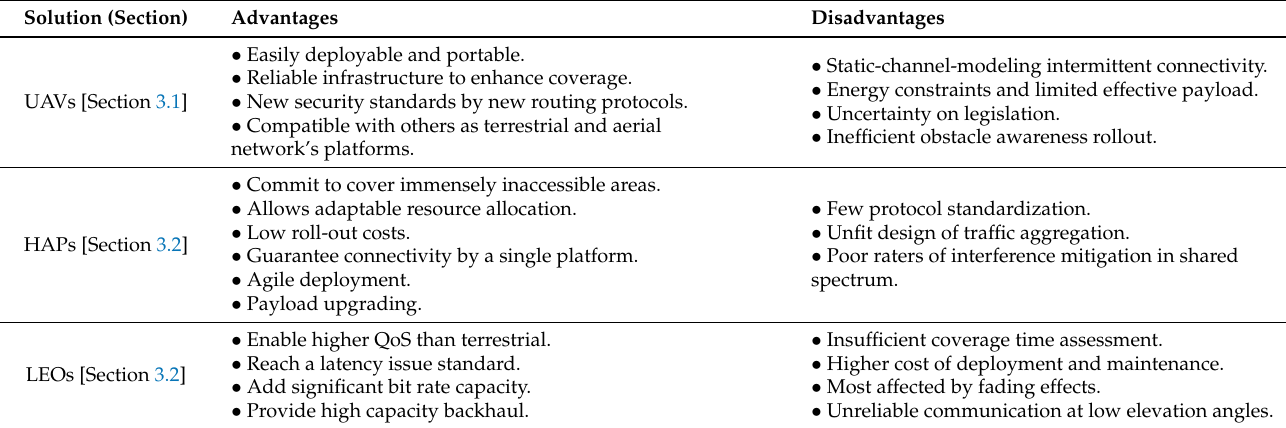
Table 7. Comparison among the analyzed solutions for rural